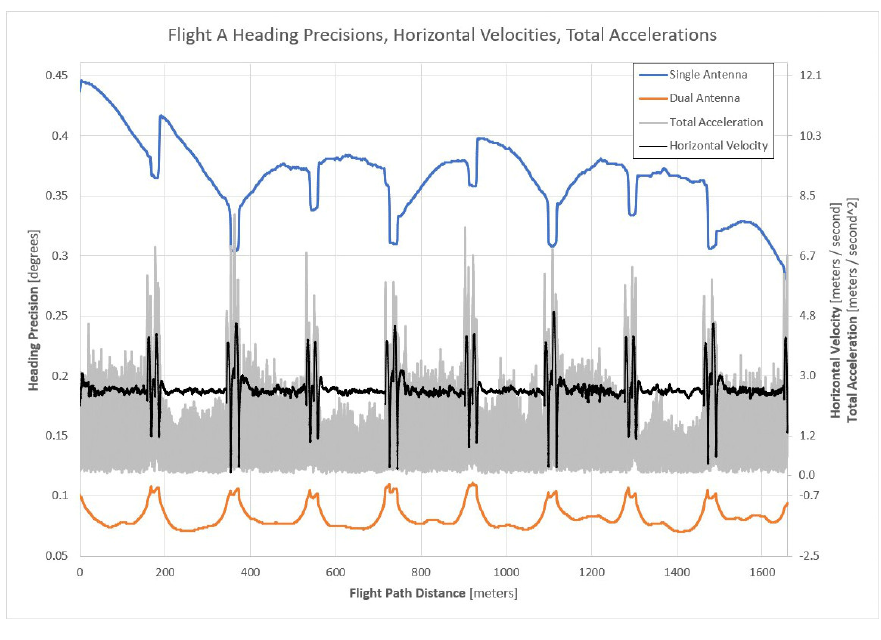
Figure 8. Single and dual-antenna GNSS/INS heading precisions, horizontal velocities, and total accelerations for flight A of the experiment.